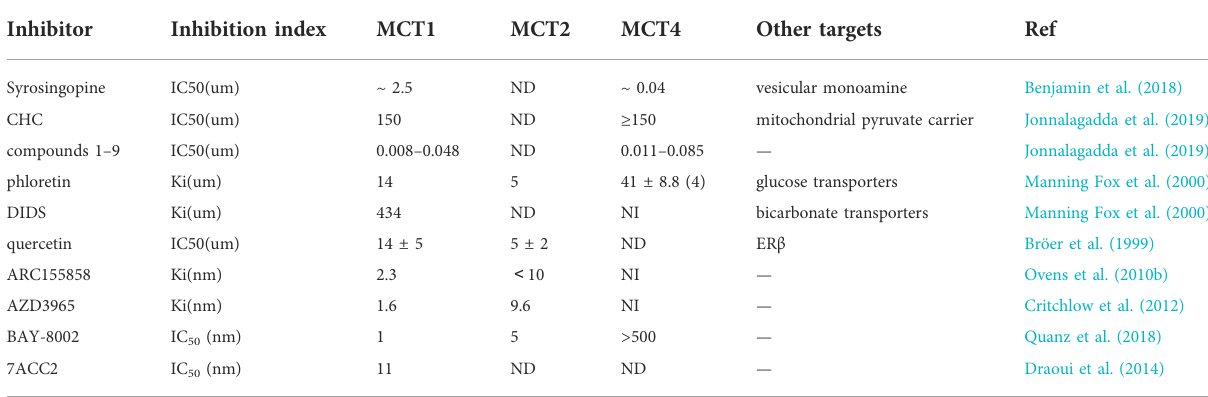
TABLE 3 Ef fi cacy of MCTs